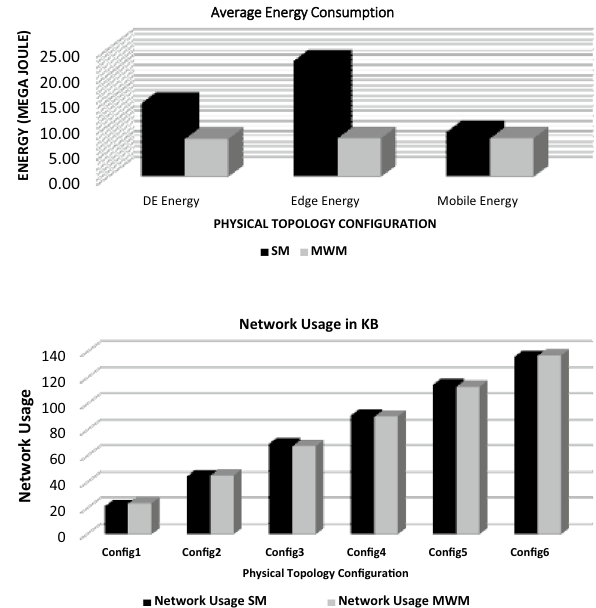
Physical Topology